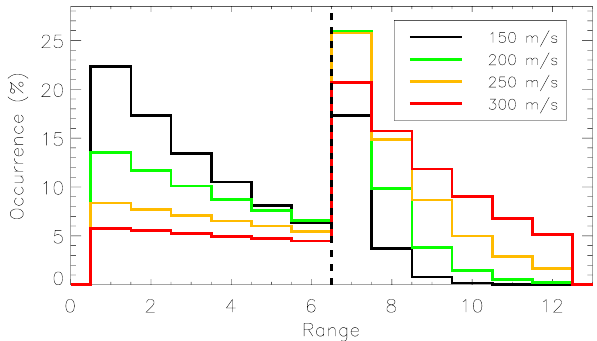
Fig. 1. The percentage occurrence of the location of the first range gate above the spectral width boundary as determined theoretically for algorithm 1. The results are presented for the 4 different spectral width thresholds used in the analysis (150, 200, 250, and 300